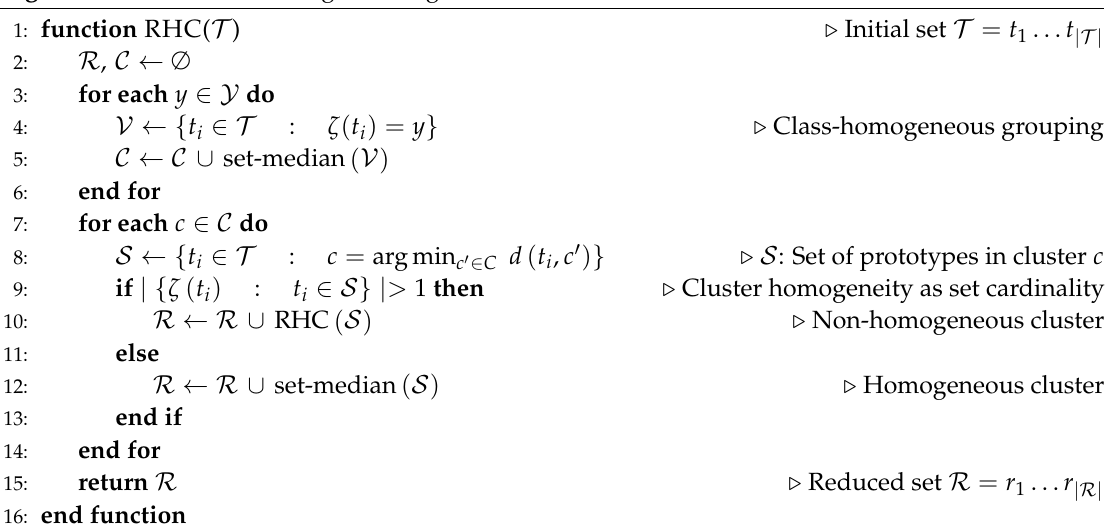
RHC algorithm retrieves a reduced version R out of the initial set T using Algorithm 1. Algorithm 1 Reduction through Homogeneous